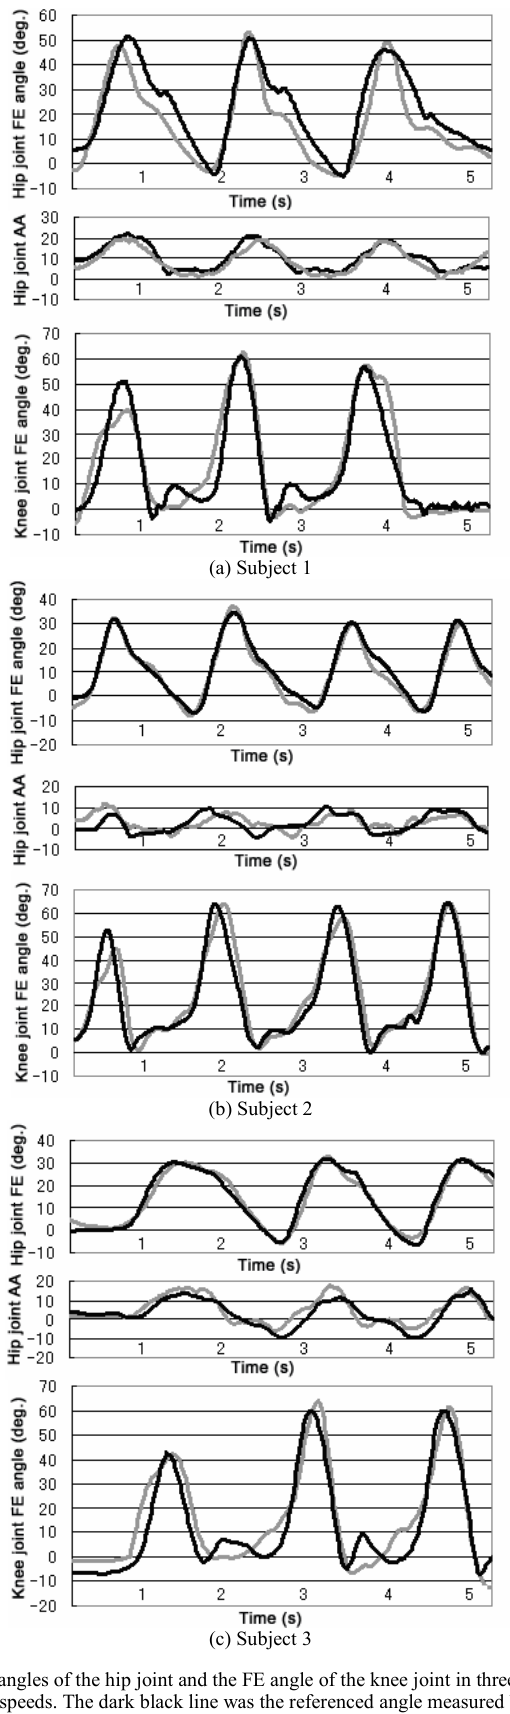
Fig.6. The FE and AA angles of the hip joint and the FE angle of the knee joint in three trials by three different subjects at self-selected speeds. The dark black line was the referenced angle measured by the camera system and the light gray line was the calculated angle using measured signals measured by the developed wearable